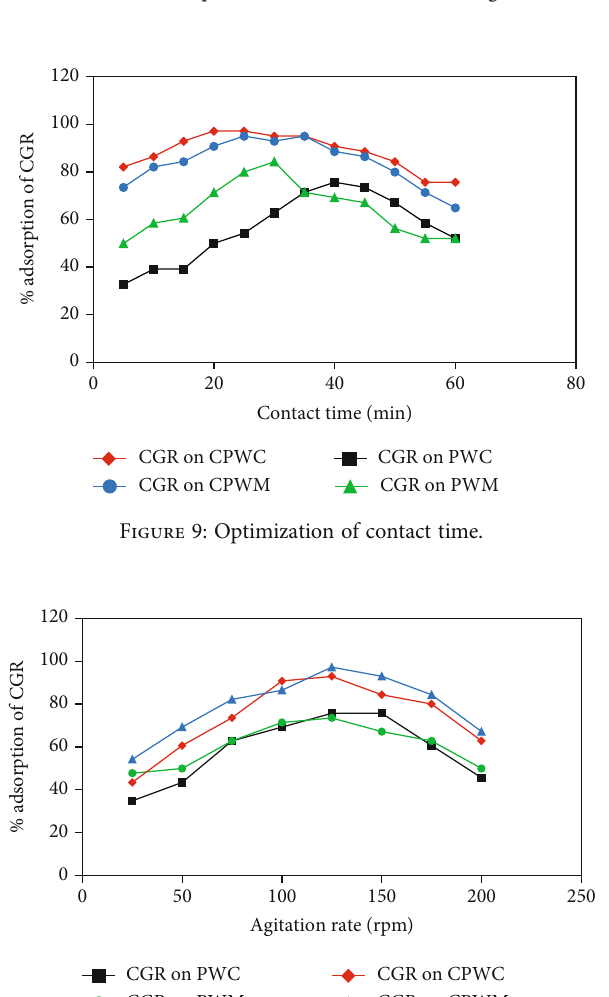
Figure 8: Optimization of biosorbents dosage.